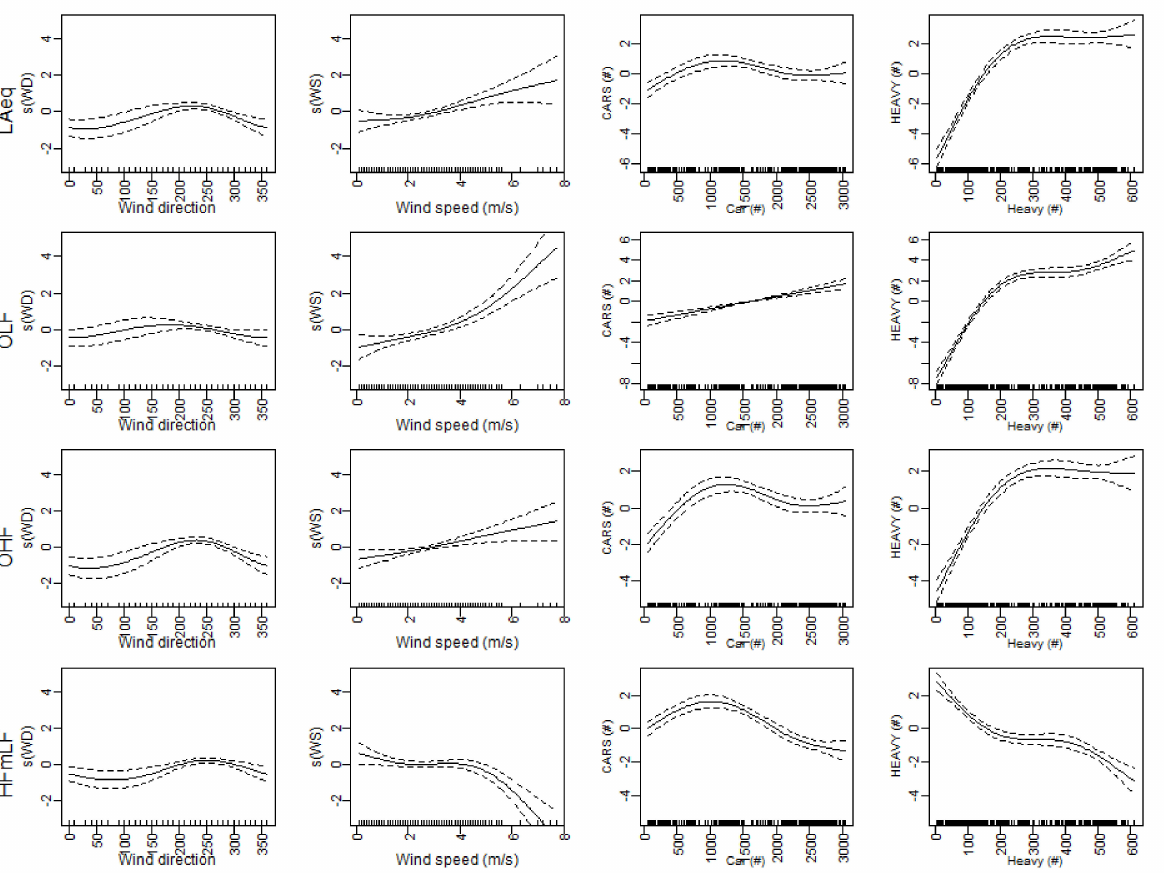
Figure 4. Four sets of GAM models for the noise parameters: L Aeq , OLF, OHF and